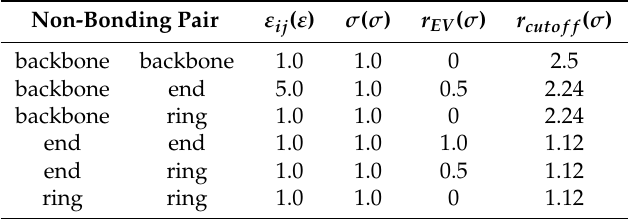
Table 1. Potential parameters of the non-bonding interaction.